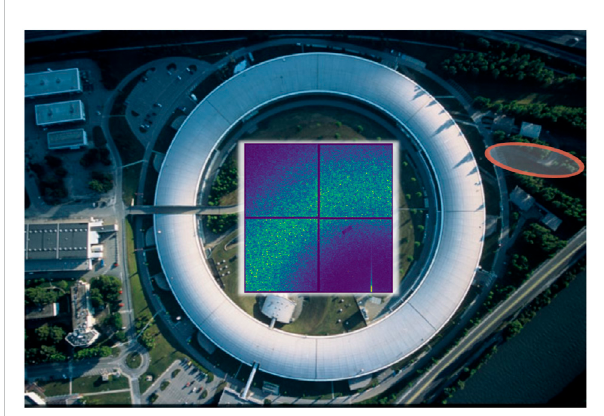
FIGURE 2 Aerial view of ESRF; the orange oval indicates the location of the new beamline devoted to the use of coherent x-rays currently under construction. Coherent x-rays have laser-like properties and produce speckle patterns when they illuminate disordered systems such as a protein solution. An example of speckle pattern is shown in the central part of the image. Since the speckle pattern encodes the position of each scatterer, they can be used to measure diffusion